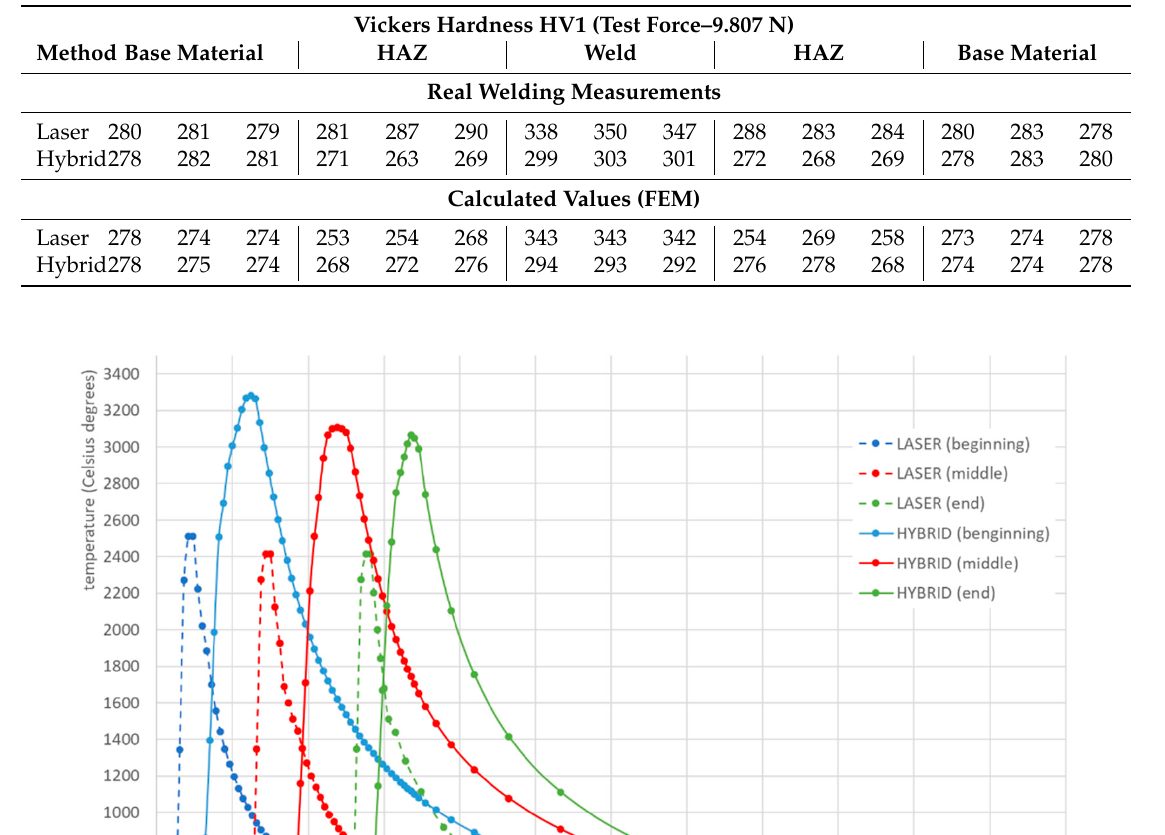
Table 6. Comparison of measured and calculated hardness values in laser and hybrid welding of S700MC steel T-joints with a thickness of 10 mm. HAZ—heat-affected zone; FEM—finite element modeling.